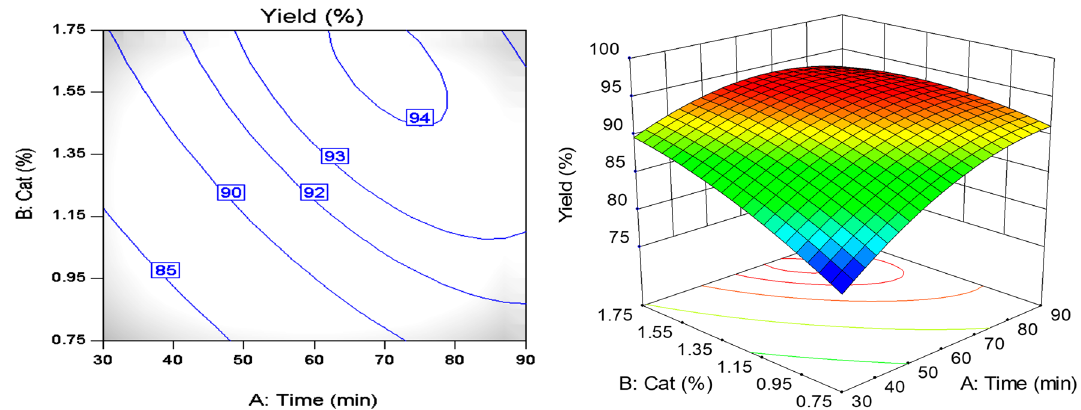
Figure 8. Interaction effect of reaction time and catalyst concentration on bio-lubricant yield.